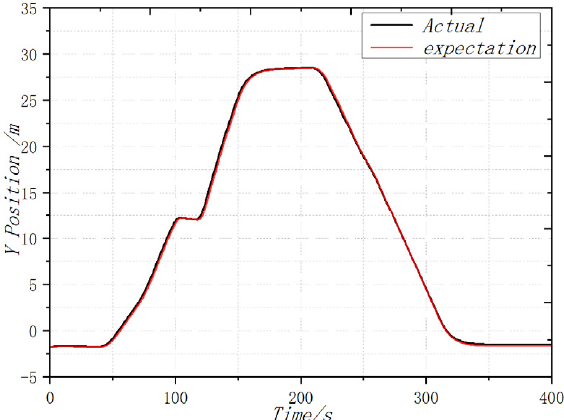
Figure 12. Expected value and actual value of dynamic flight Y direction.